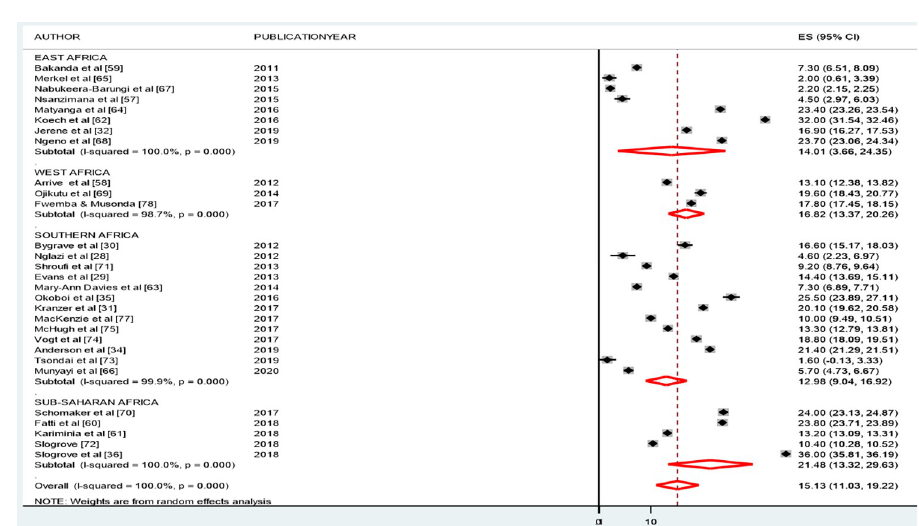
Fig 6. Subgroup analyses by the broad categories of across national countries on loss to follow-up among adolescents living with HIV and on ART follow-up in SSA.